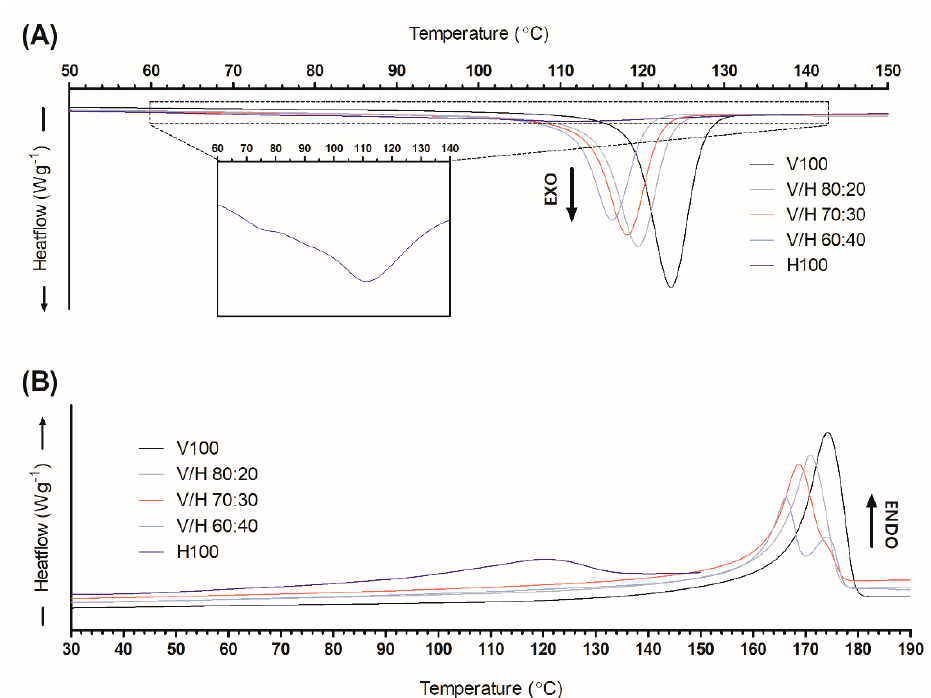
Figure 5. Cooling ( A ) and second-heating ( B ) curves of poly(3-hydroxybutyrate- co -3-valerate) (PHBV), poly(3-hydroxybutyrate- co -3-hydroxyhexanoate) (PHBH), and their blends with PHBH crystallization curve detailed.